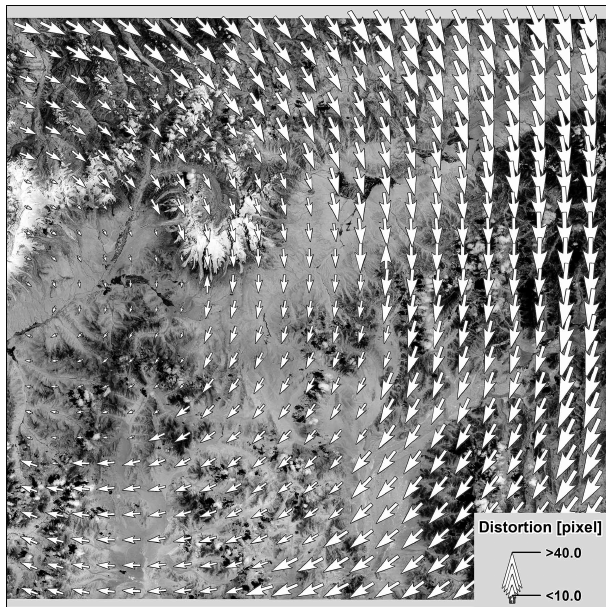
Figure 2. Distortion vectors of réseau crosses from their measured to their initial reference positions in a KH-9 photograph segment covering Muztagh Ata (frame 17a of mission